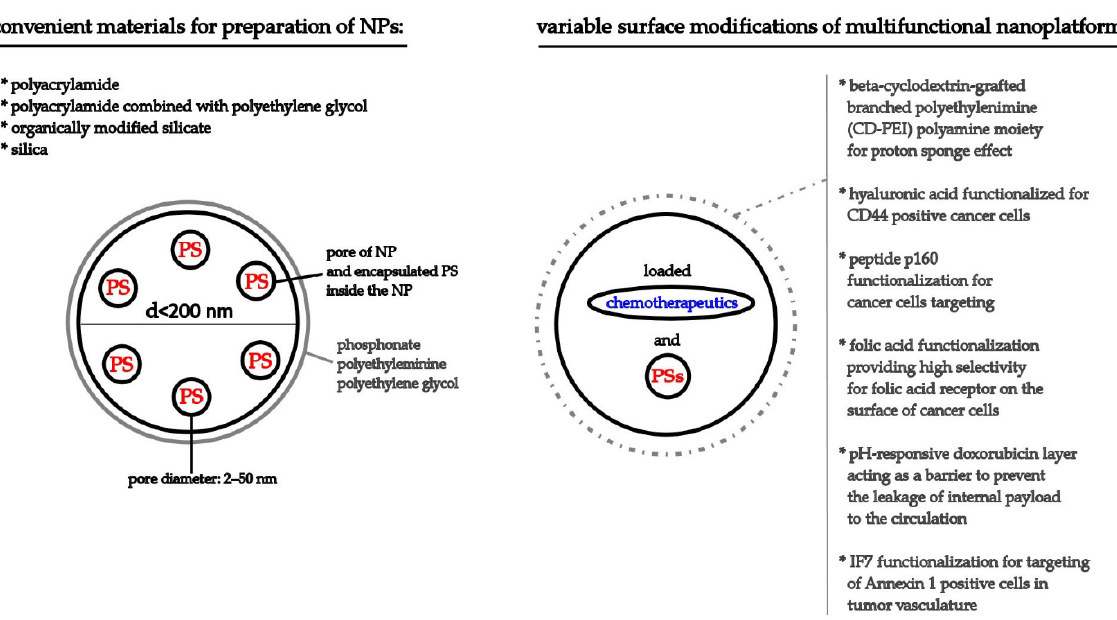
Figure 3. Graphical representation of NPs convenient for application in DNP concept of PDT ( A ) and multifunctional therapeutic approaches for application in combined chemo-PDT ( B ).